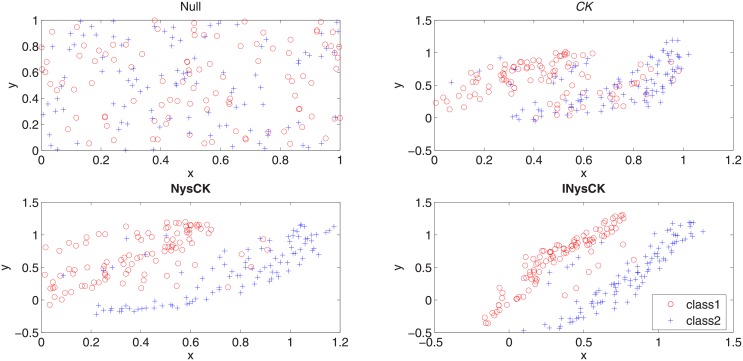
Distributions of samples with different CK-related methods on a binary-class data set.